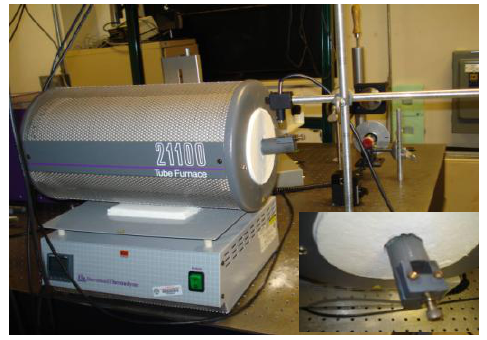
Figure 4. Block diagram of the fluorescence lifetime sensing setup